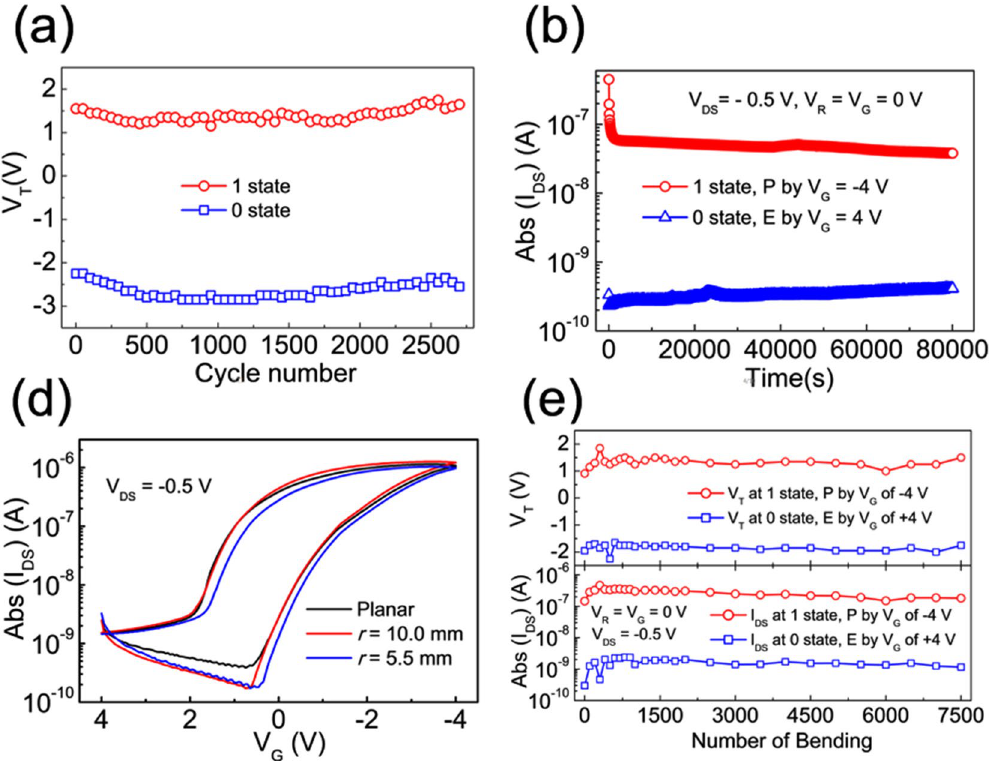
Figure 4. ( a ) Memory switching endurance and ( b ) data storage retention characteristics of the low-voltage operating flexible Fe-OFET NVM with a 60 nm thick P(VDF-TrFE-CTFE) ferroelectric film. ( c ) Transfer characteristics of the low-voltage operating flexible Fe-OFET NVM measured at the planar and bending states, respectively. ( d ) Mechanical fatigue property of the low-voltage operating flexible Fe-OFET NVM measured at a bending radius of 5.5